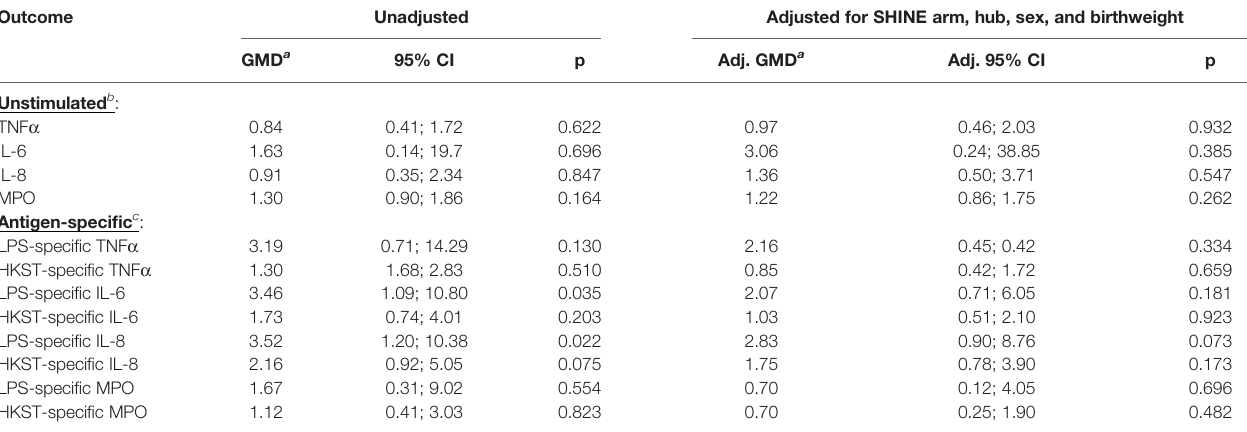
Table 4 ). Neither proportions nor concentrations of other mediators in unstimulated cultures differed by the WASH arm ( Figure 4A ; Table 4; Supplementary Table 8 ). Higher proportions of children in the WASH versus no WASH arm had detectable bacterial antigen-speci fi c responses; this effect was